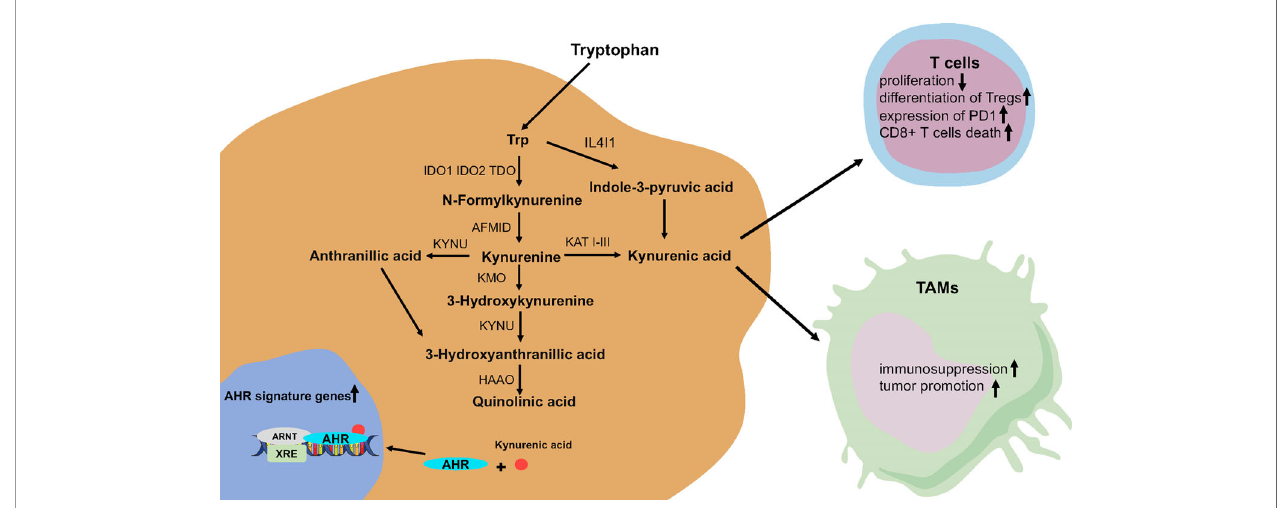
FIGURE 1 | The tryptophan catabolic pathway in glioma. AFMID, kynurenine formamidase; AHR, aryl hydrocarbon receptor; HAAO, 3-hydroxyanthranilate 3,4- dioxygenase; IDO, indoleamine-2,3-dioxygenase; KATs, kynurenine amino transferases I – III; KMO, kynurenine 3-monooxygenase; KYNU, kynureninase; TDO,